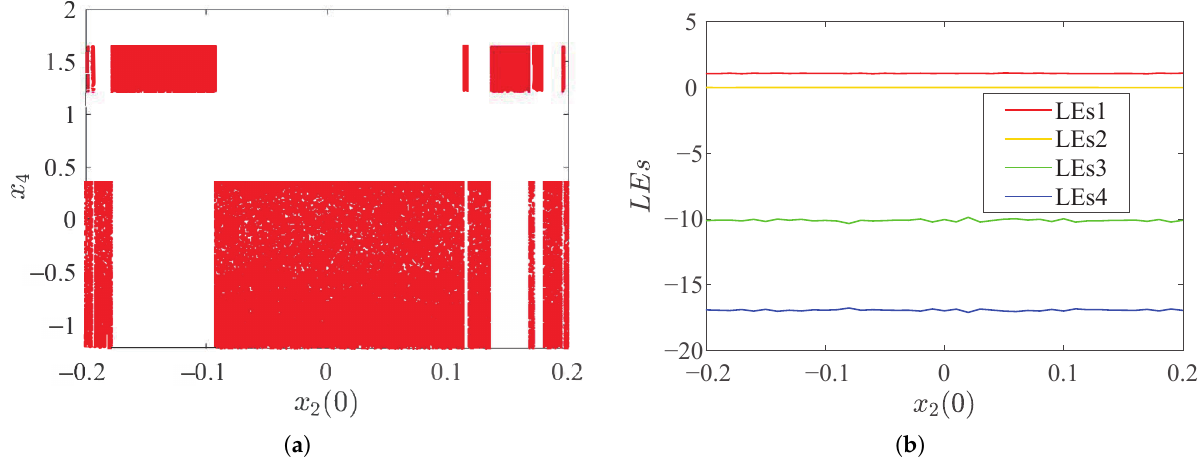
Figure 10. Dynamical behaviors with changes in initial value x 1 ( 0 ) of system (15). ( a ) Bifurcation diagram; ( b ) LEs.